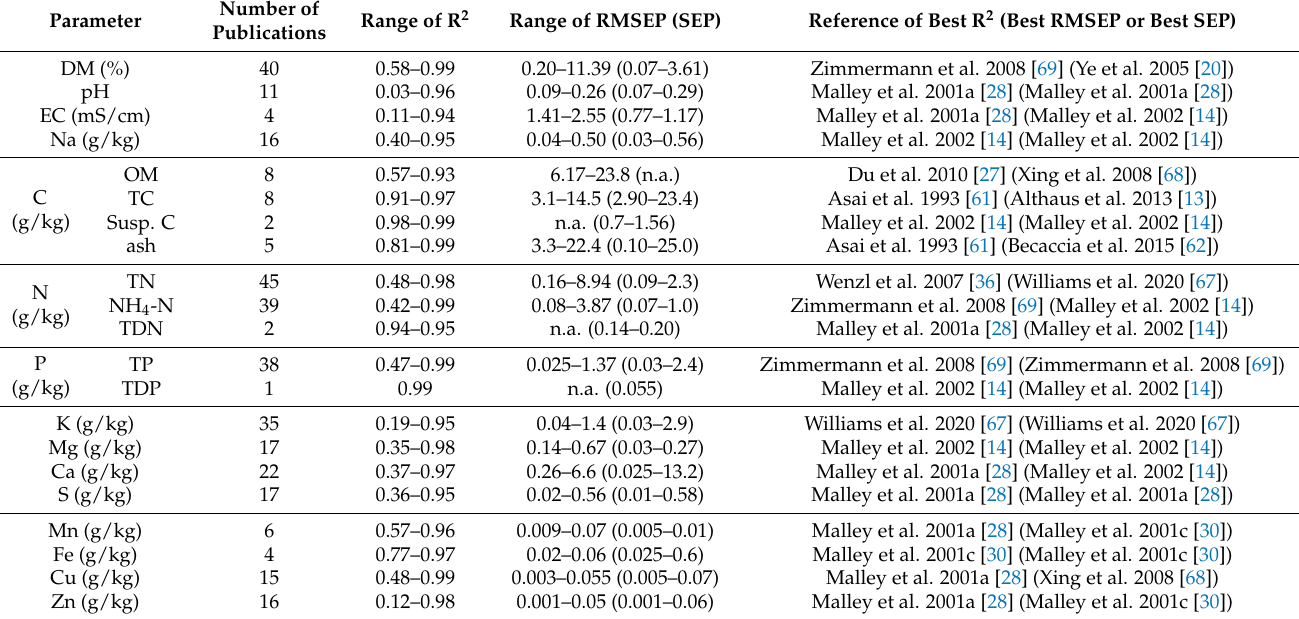
Table 6. Summary of published data displayed in Tables 1–5 describing parameters of liquid organic manures with optical